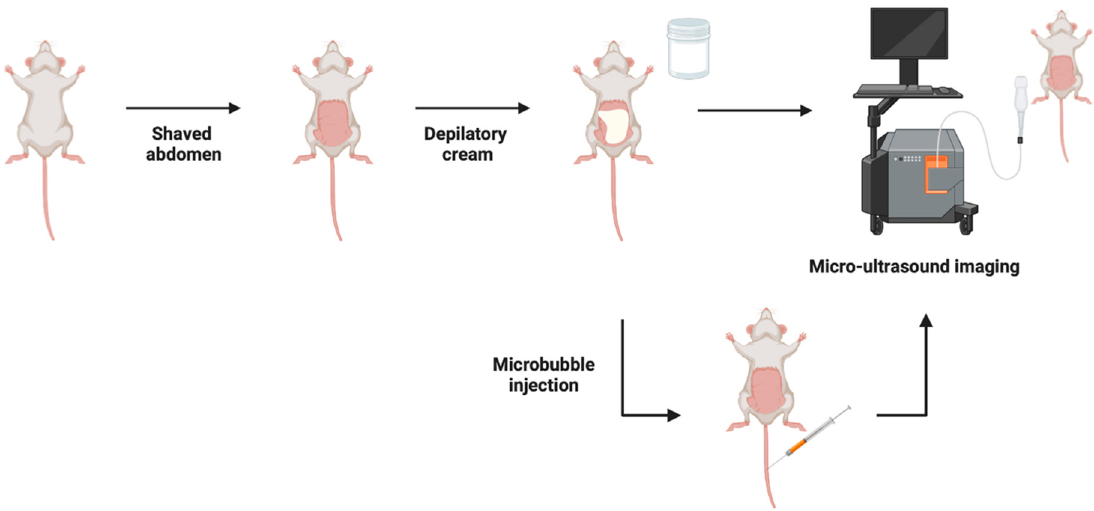
Figure 2. Micro-ultrasound imaging (MUI) method in an intravesical model of BCa where the abdomen is shaved, depilatory cream is applied to remove fine hairs, and high viscosity ultrasound gel is utilized during imaging to enhance the image resolution. Subsequent studies administered microbubbles via intravenous injection prior to imaging for visualization and quantification of the superficial tumor vasculature. Figure prepared with BioRender (biorender.com, accessed on 1 February 2023).